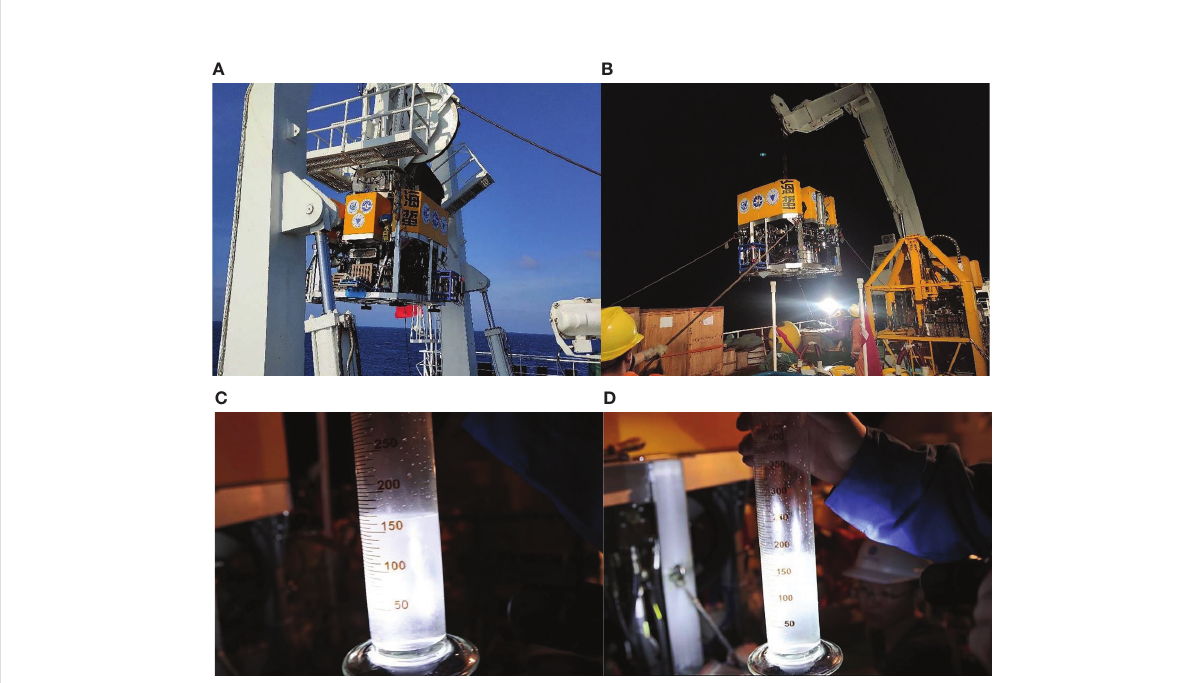
FIGURE 12 Prototype test and sampling process, (A) The arrangement of the water sampler, (B) The recovery of the water sampler, (C) Water extraction of channel 2, (D) Water extraction of channel 3.